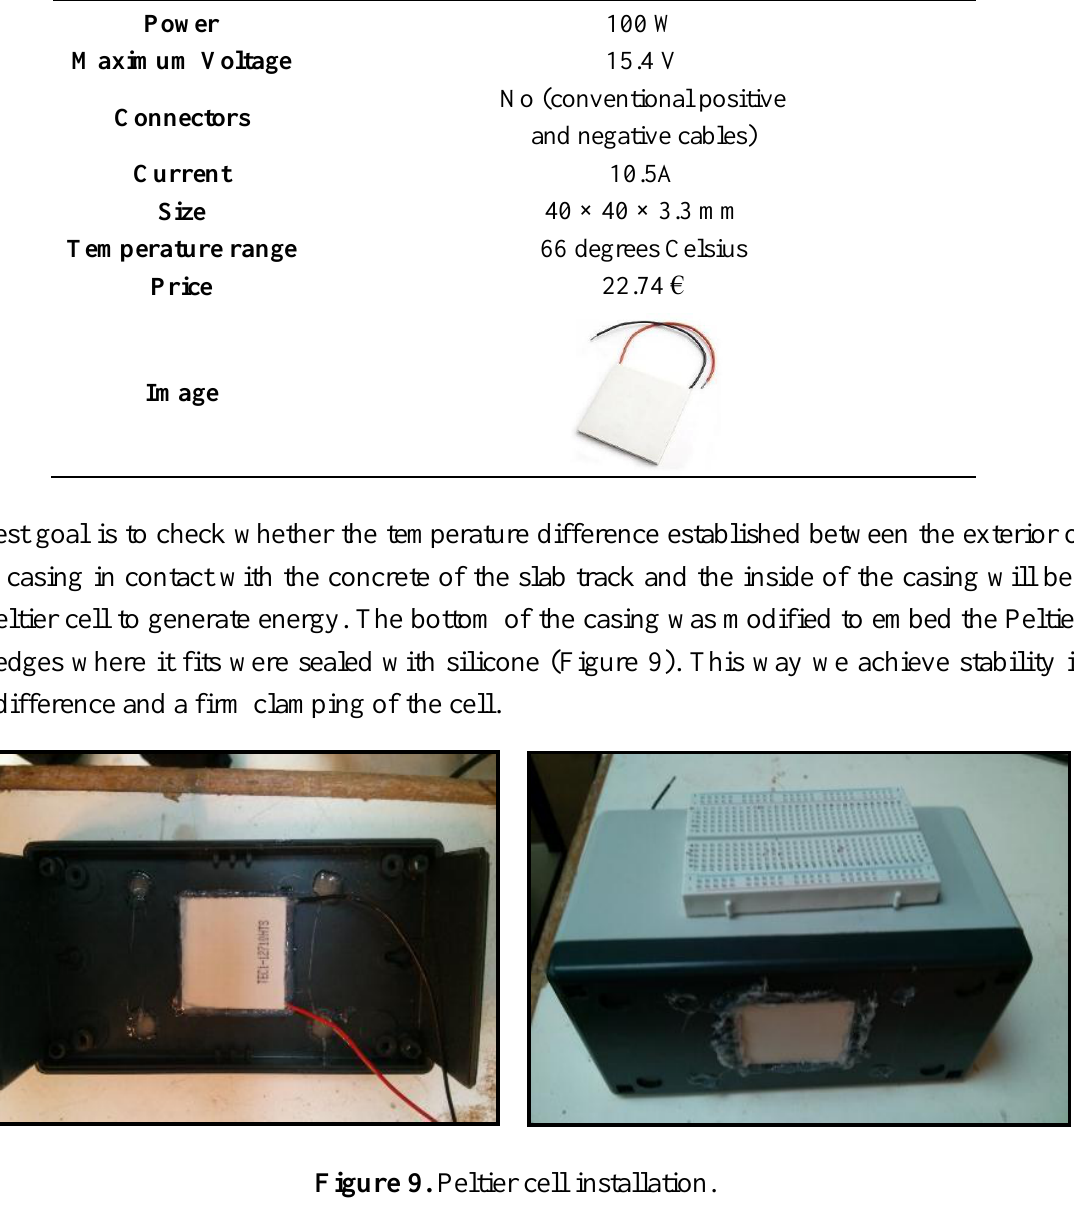
Figure 9. Peltier cell